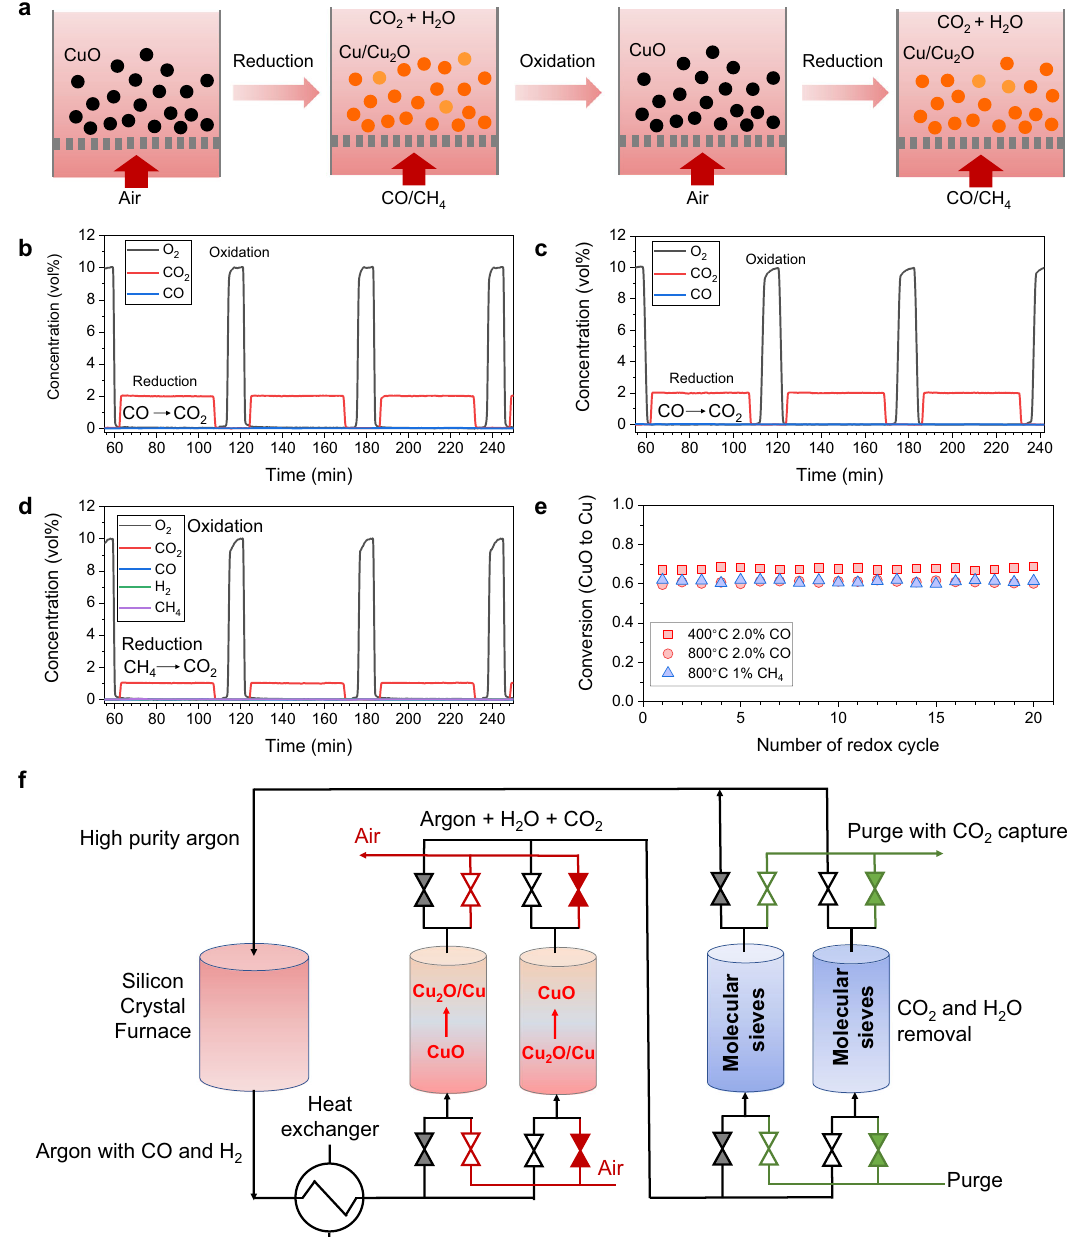
Fig. 7 | Ef fi cient gas puri fi cation by thermochemical redox cycling of MMOs. a Schematic diagram of the main redox-reactions of MMO upon reduction in dilutedCOandCH 4 ,andoxidationunderair, b – d Gasconcentrationpro fi lesduring redox-experimentswith reductionin2.0vol%CO at (b)400°Cand (c)800°C;and d reduction in CH 4 at 800°C. e Conversion of oxygen sorbents versus number of